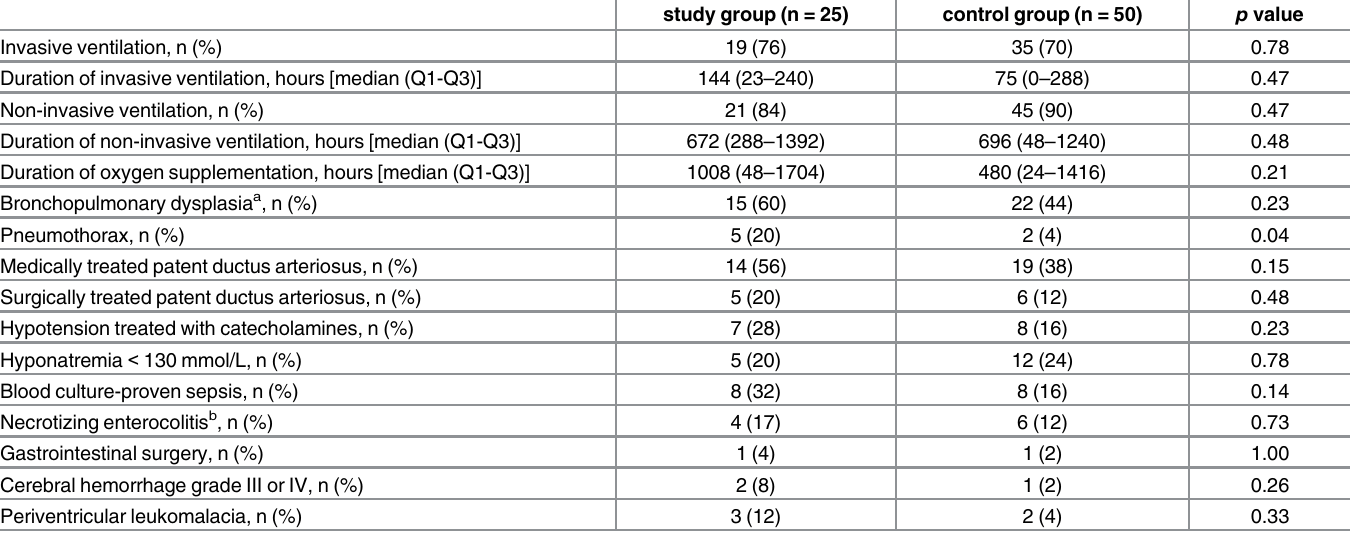
Table 4. General clinical